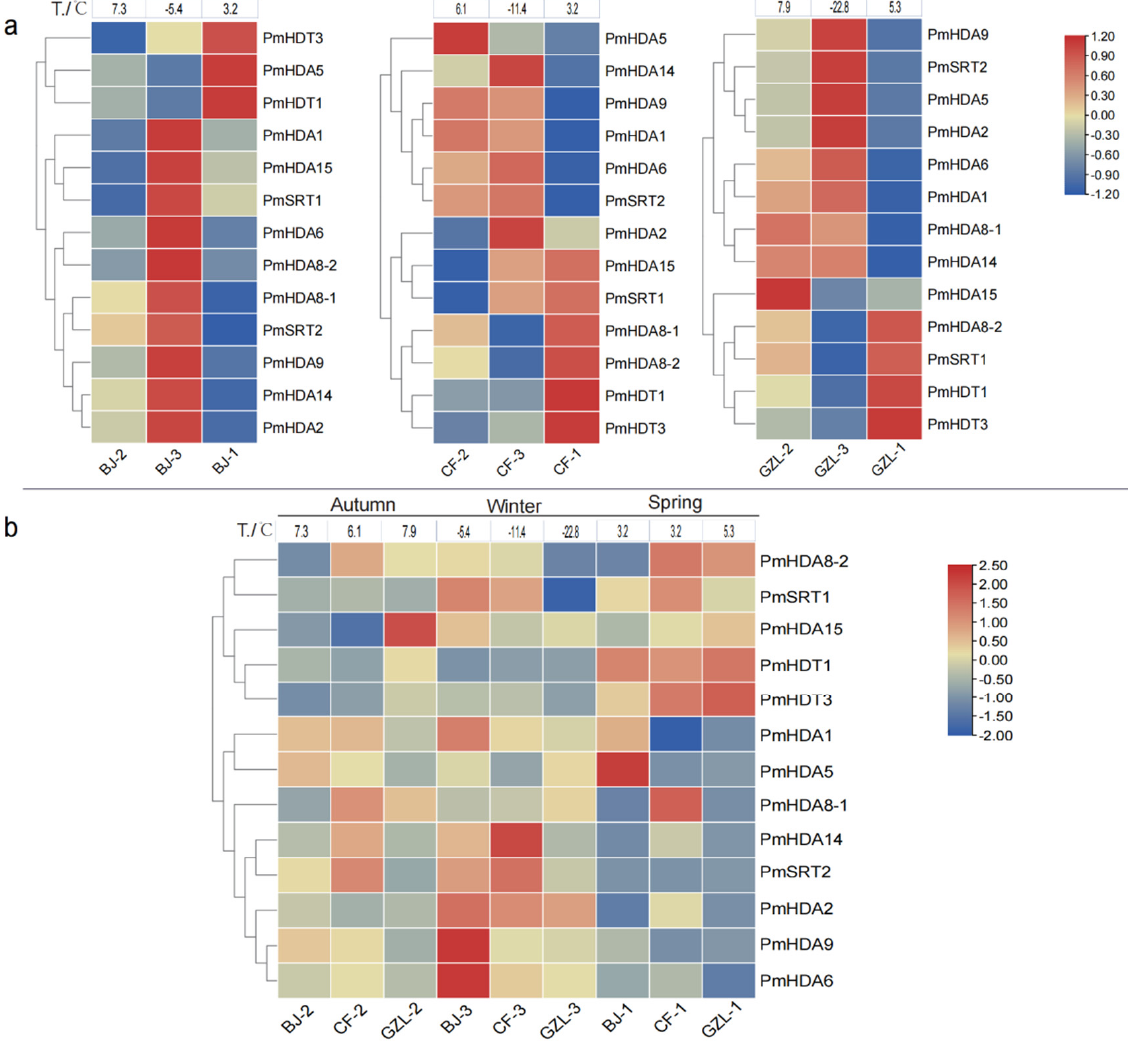
Figure 9. Expression accumulation in stems of cold − insensitive cultivar ‘Songchun’ under three natural low temperatures (1, 2, 3) at three test sites: Beijing (BJ), Chifeng (CF), and Gongzhuling (GZL). ( a ) Expression comparison profiles of PmHDACs in different seasons at the same test site. ( b ) The expressions of PmHDACs in different test sites. The numbers up − on the heatmap represent the temperature in this stage. In three temperatures, the 2nd stage was the autumn deciduous period, the 3rd was the winter bud dormancy period, in which the temperature is the lowest, and the 1st was the germination period in early spring. Cold acclimation period began with the 2nd to 3rd stages and was lost at the 3rd to 1st stage. The legend represents the FPKM values of gene expressions from RNA − seq after they were normalized with the row scale method.